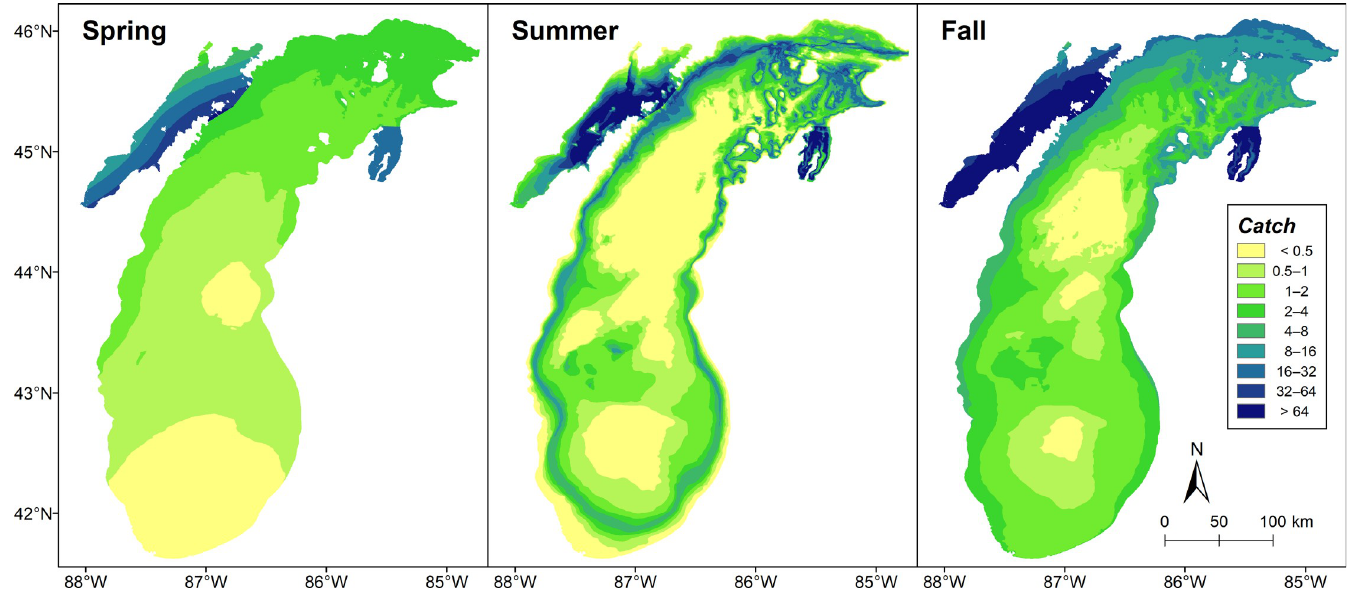
Fig 6. Maps for historical cisco distribution in Lake Michigan by season, 1930–1932. Cisco catch was predicted by using the selected generalized additive model fitted to the Fulmar data and was standardized to per panel of gill net with a 60-mm mesh size and a sampling duration of four nights. The maps were generated by using a geographic information system (GIS) software ArcGIS version 10.4 (http://www.esri.com/software/arcgis/). The GIS map layers for predicted cisco catch were generated in this study. The GIS map layers for Lake Michigan was obtained from Great Lakes Aquatic Habitat Framework’s [25] public domain spatial database (https://glahf.org/